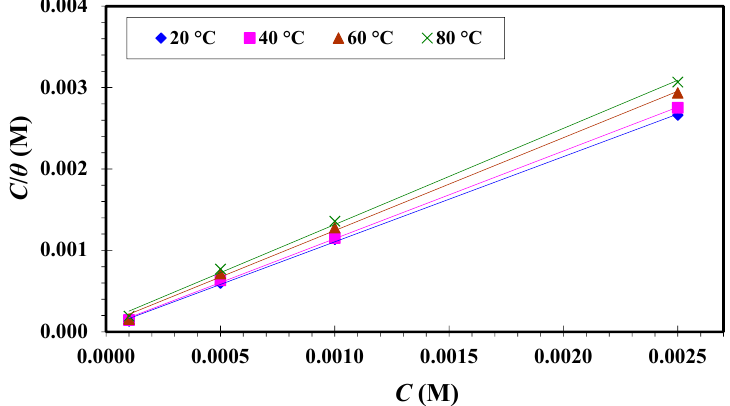
Figure 17. Langmuir isotherm adsorption model for CGSES14 on the MS surface in 1 M HCl at different temperatures. Materials 2020 , 13 , x FOR PEER REVIEW 20 of 31